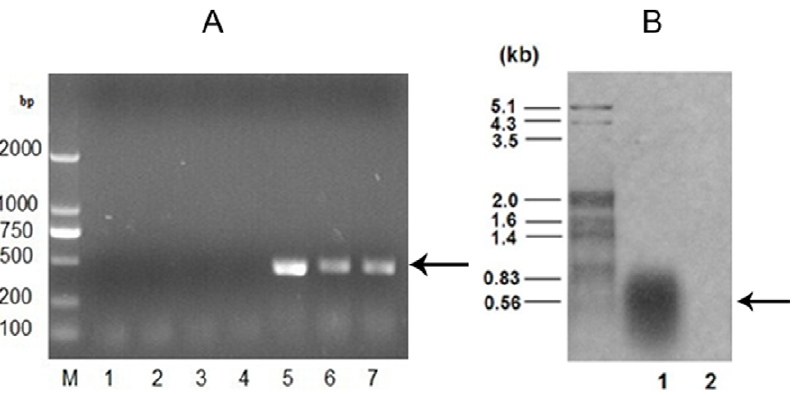
Figure 4. Shble gene transcripts in transformant MT-B. Panal A is the RT-PCR analysis of MT-B strains and PCR amplification with total RNA. M: DL2000 marker, Lane 1: cDNA of negative control CC-2654 used as template; 2–4: total RNA isolated from different MT-B strains used as template; lane 5–7: cDNA of different MT-B strains used as template. Panal B is the Northern blot analysis of C. reinhardtii MT-B. Lane 1, total RNA of MT-B was detected with Sh ble probe; lane 2. total RNA of CC-2654 was used as negative control.